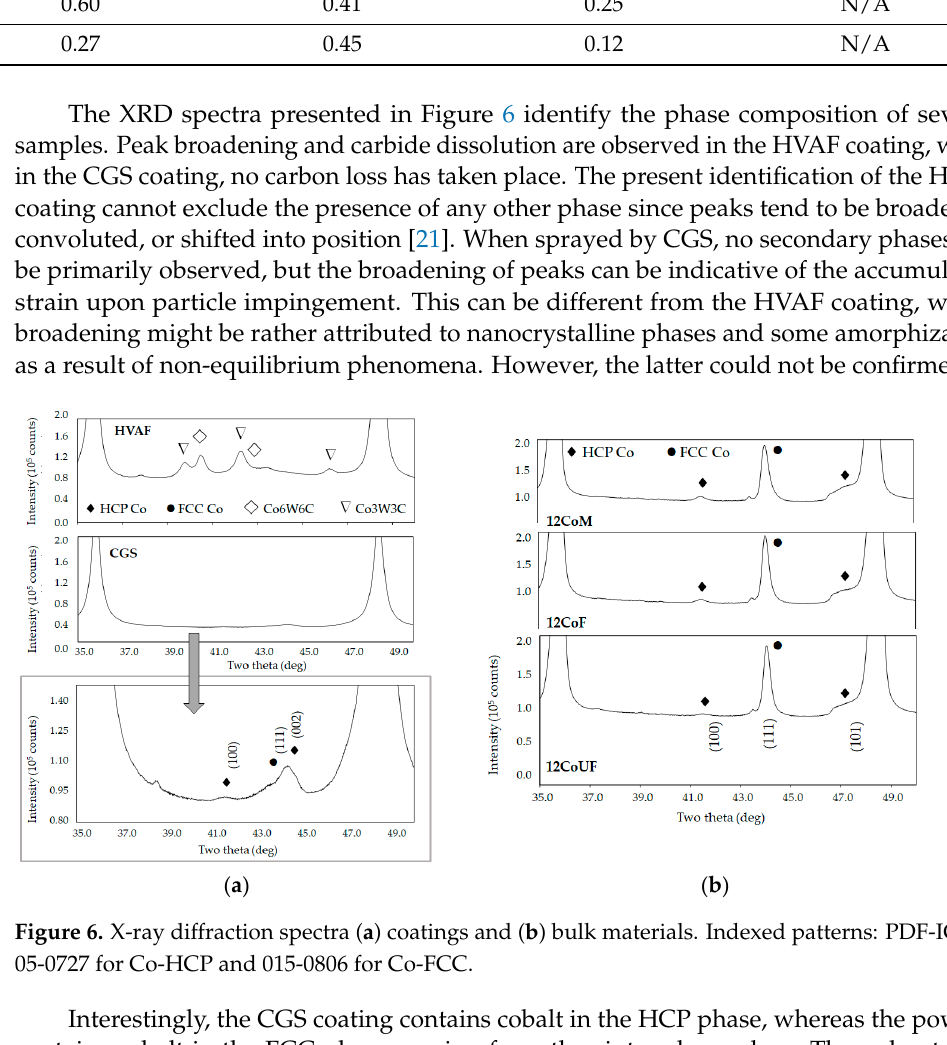
Table 2. Microstructural parameters of the examined samples.